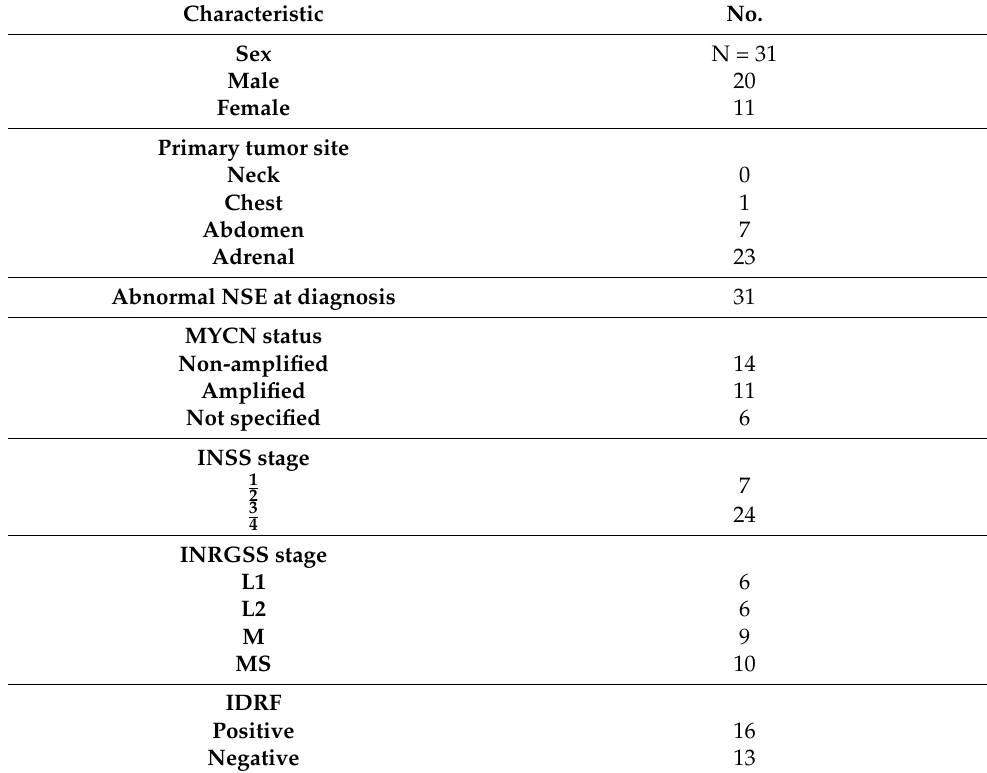
Table 2. Demographic, clinical, and biological